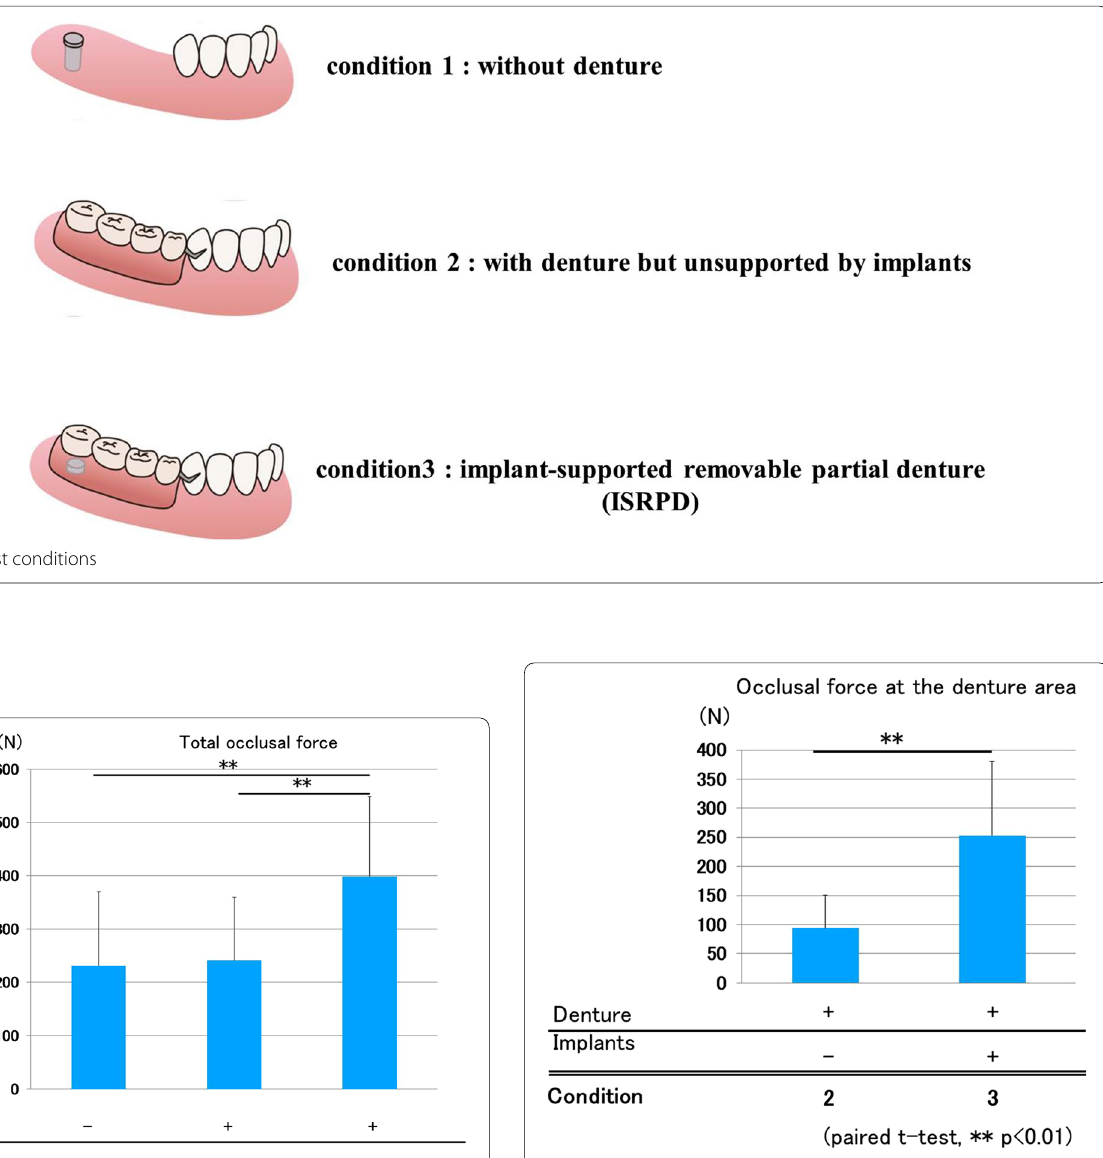
Fig. 4 Occlusal force at denture area. Condition 3 (ISRPD) showed significantly greater occlusal force at the denture area compared with Condition 2 (removable partial denture without implant support; paired t -test, p <